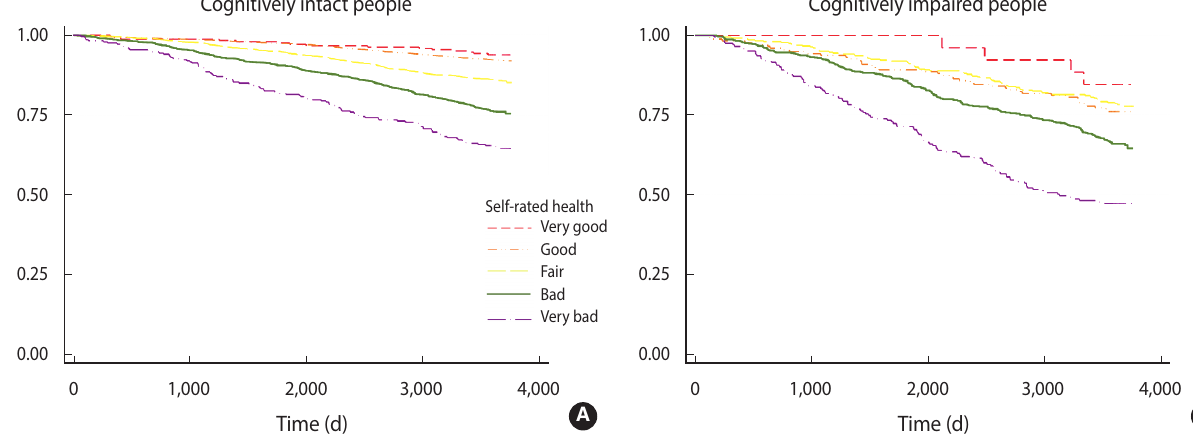
Figure 1. Kaplan-Meier estimates for self-rated health on mortality over ten-years (2006-2016) across different cognitive status (A) intact and (B)